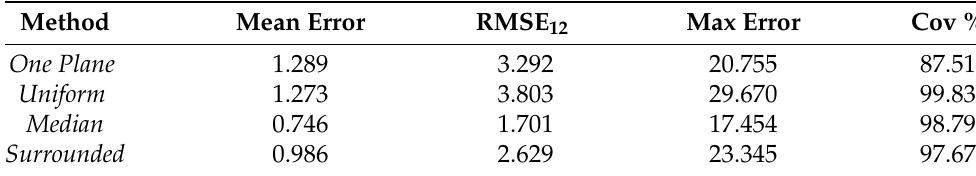
Table 7. Comparison, using METRO , between the different partitioning methods and the original mesh. Cov % is the coverage percentage of the original model. The Median method shows the better performance in all the metrics.